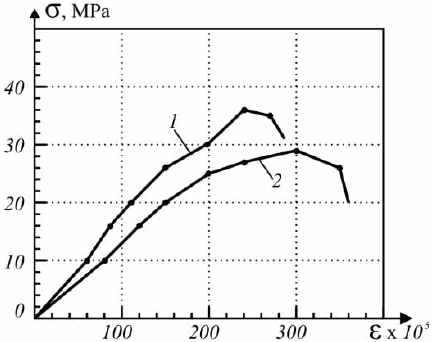
Fig. 2. Deformation character of hardened sulphur during compression: (1) non-plasticised, (2)